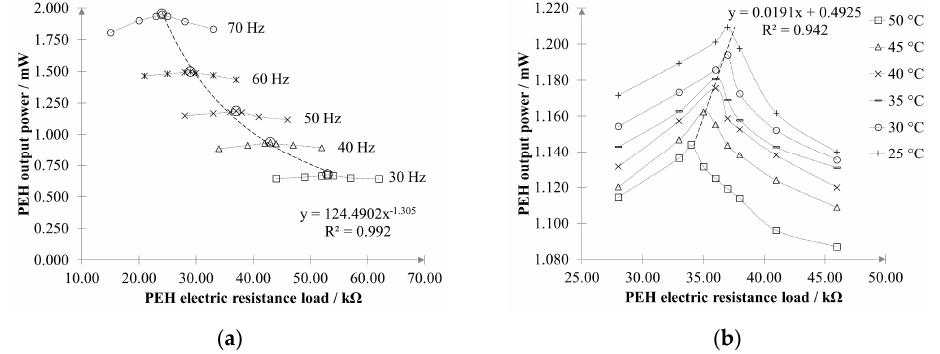
Figure 3. ( a ) Effect of the vibration frequency on PEH output power (at a fixed temperature of 25 °C) and ( b ) effect of the working temperature (while keeping the vibration frequency at 50 Hz).